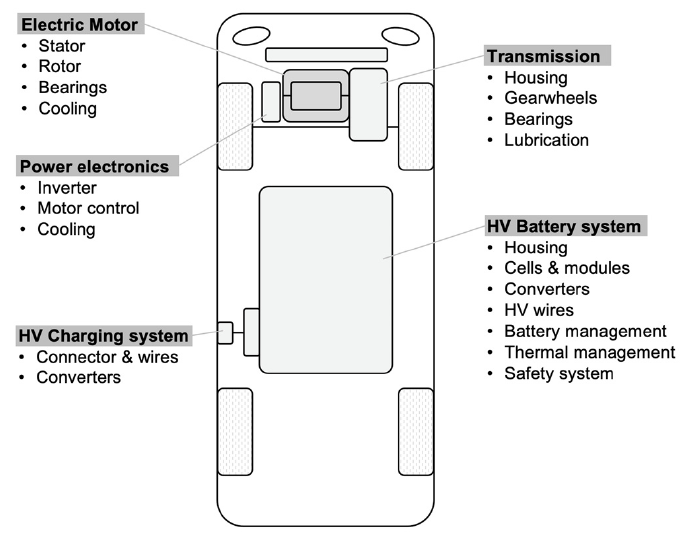
Figure 10. Powertrain structure of electric cars.